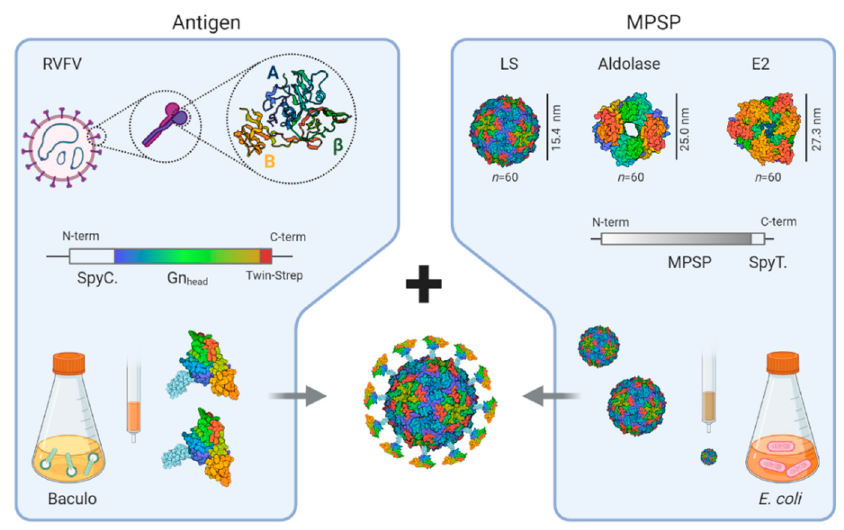
Figure 1. Graphical presentation of the multimeric protein scaffold particles (MPSPs)-based Rift Valley fever virus (RVFV) candidate vaccines. The RVFV-Gn head domain comprising the A (I), β (II), and B (III) subdomain was N -terminally linked to a SpyCatcher domain and a C -terminal Twin-Strep-tag. Following expression using the baculovirus expression system, the subdomains were purified by Strep-Tactin column chromatography. Lumazine synthase (LS)-, Aldolase-, and E2-based MPSPs with C -terminal SpyTags were expressed in E. coli . Upon mixing, the SpyCatcher, fused to the N -terminus of Gn head forms a spontaneous isopeptide bond with the SpyTag present on the MPSPs, yielding antigen-decorated nanoparticles for immunization.